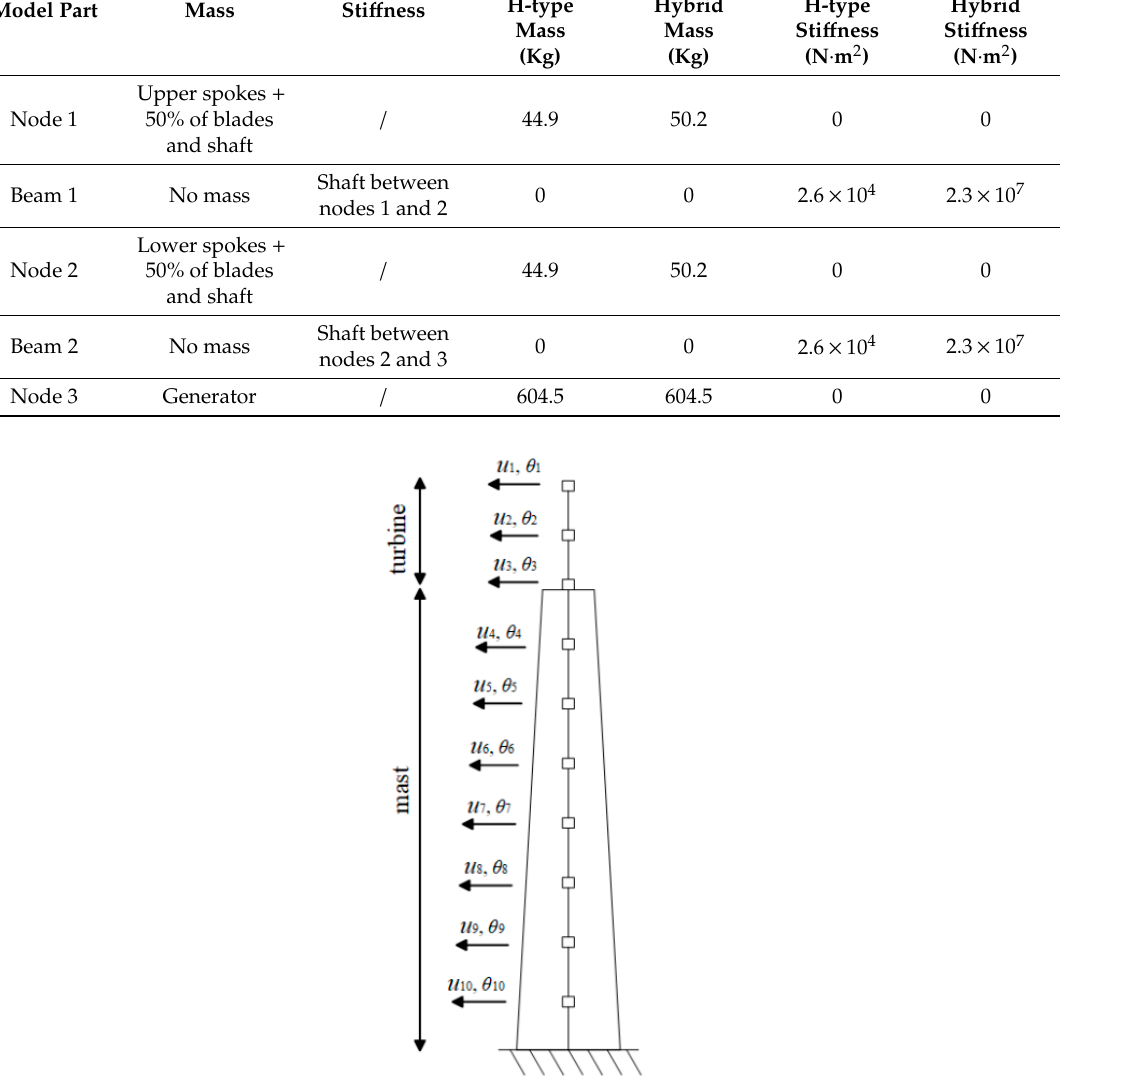
Figure 5. Schematic of the MDOF model of the two VAWTs.